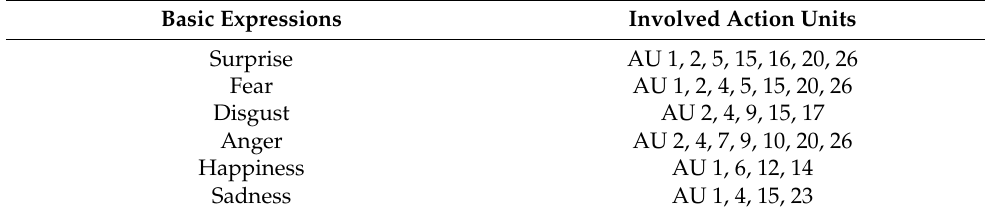
Table 4. List of AUs involved in basic expressions.